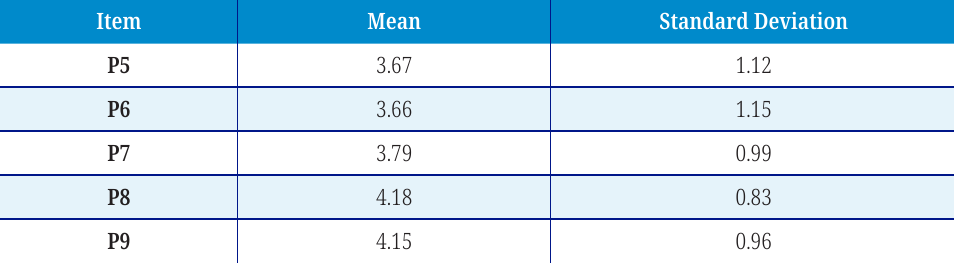
Table 5. Mean obtained by dimension 2 items